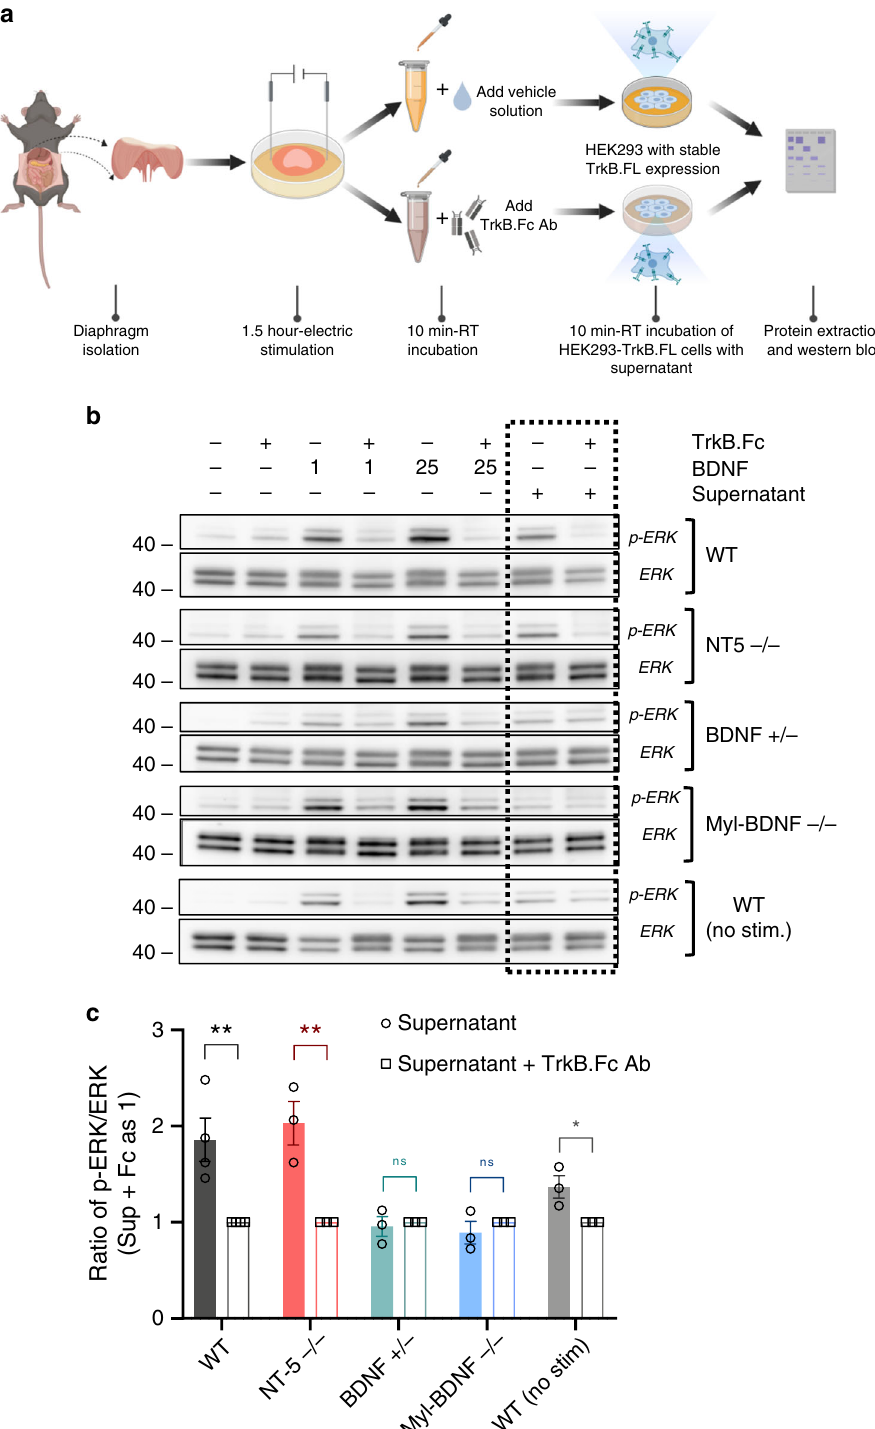
Fig. 7 Mouse skeletal muscle secretes BDNF. a – c Skeletal muscle secrete biologically active BDNF. a Schematic representation of the procedure used to test diaphragm BDNF secretion and BDNF biological activity. The illustration was created using BioRender (https://biorender.com/). b Representative western blot analysis of phospho-ERK (p-ERK) activation relative to total ERK induced by supernatants from isolated mouse diaphragm treated as in a and incubated with or without a BDNF-neutralizing TrkB.Fc protein to test for BDNF activity (boxed last two lanes). Cells treated with 1 ng/ml BDNF (lane 3) and 25 ng/ml BDNF (lane 5) were used as positive controls. c For each genotype, quanti fi cation of supernatant activity (penultimate lane) was performed by setting the ratio of p-ERK/ERK from the supernatant with TrkB.Fc to 1 (last lane), n = 4 for WT group, n = 3 for NT5 − / − , BDNF + / − , Myl-BDNF − / − and WT (no stim.) groups. Student ’ s t -test was used for comparison, * p < 0.05, ** p < 0.01. Data represent mean ± S.E.M. Source data are provided as a Source Data fi